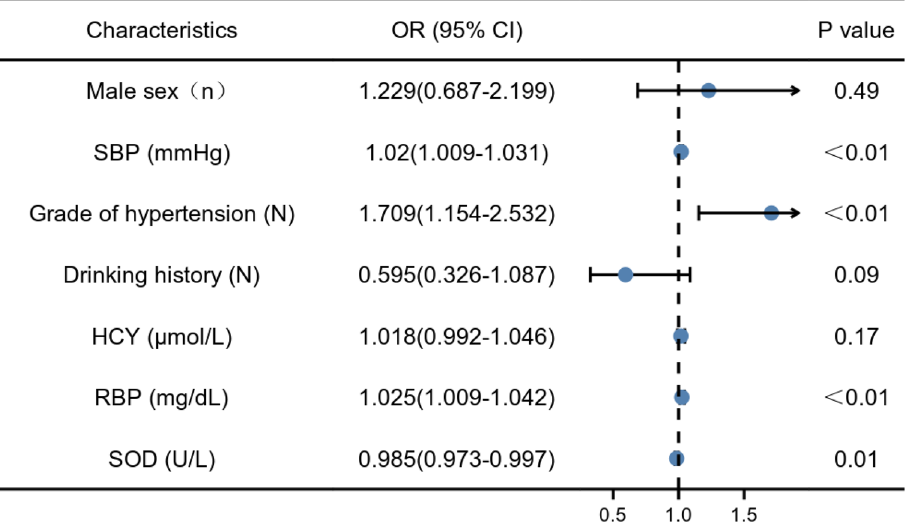
Figure 2. Multivariate logistic-analysis. SBP Systolic blood pressure, HCY Homocysteine, RBP Retinol-binding protein, SOD Superoxide dismutase.